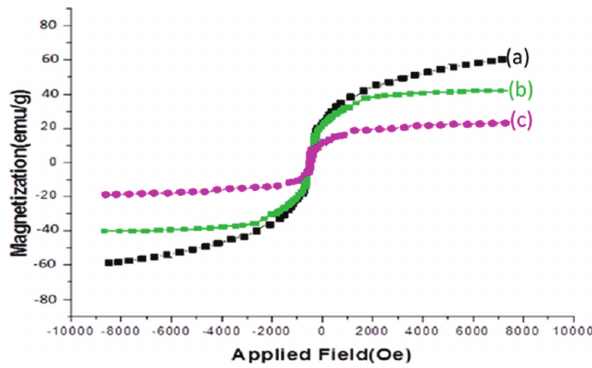
Figure 4: The VSM curve of: (a) Fe SiO -L-proline 2